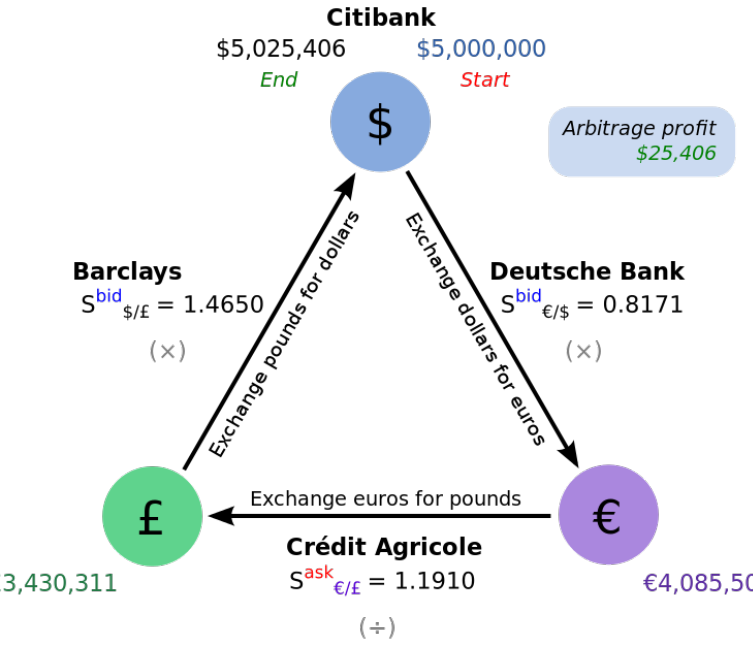
Figure 2. Triangular arbitrage. Source: [14].